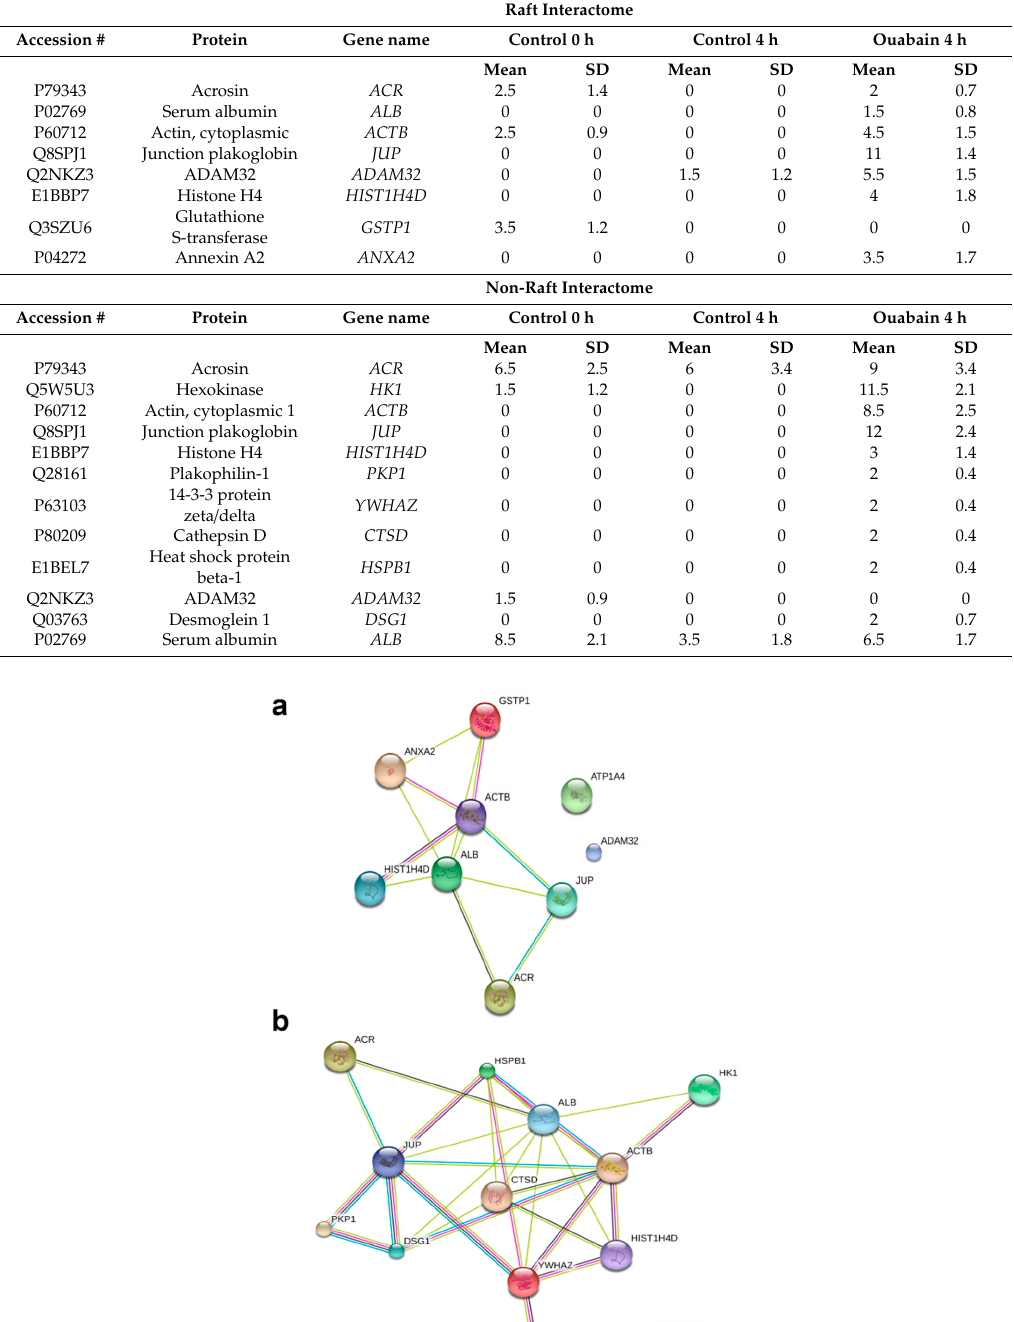
Table 1. Average normalised spectral counts of proteins identified in control and ouabain-capacitated sperm.